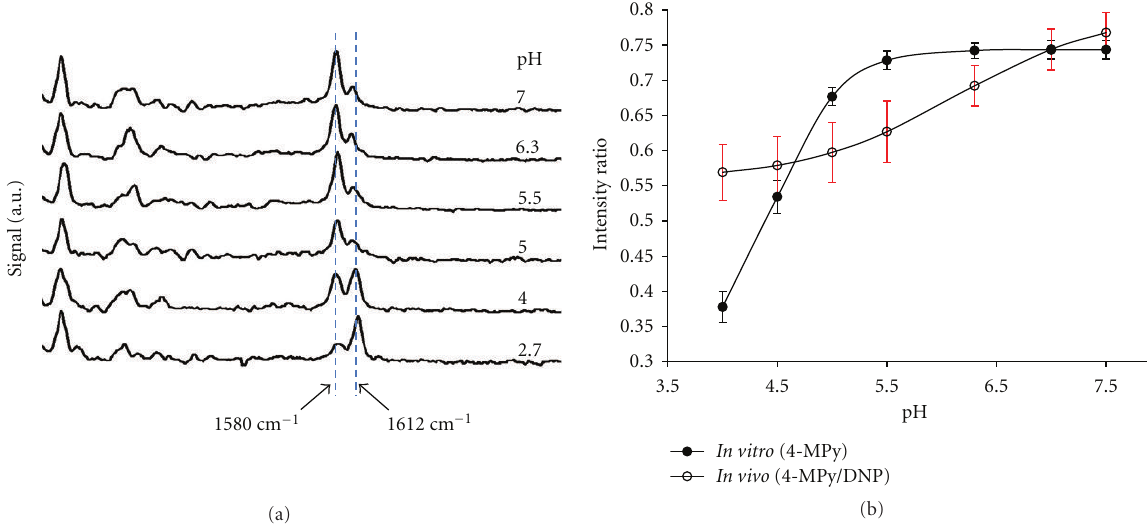
Figure 4: (a) Normalized and o ff set Raman spectra of Au@Ag-4MPy nanoparticles in varying pH-bu ff ered solutions. (b) In vitro (closed circle) calibration curve of Au@Ag-4MPy nanosensors and in vivo (open circle) calibration curves of Au@Ag-4MPy-DNP nanosensors inside RBL-2H3 cells in pH-bu ff ered media containing nigericin. Y -axis represents ratio of integration of peak centered at 1580 cm − 1 versus the additive integration of both the peak centered around 1580 cm − 1 and 1612 cm − 1 . Vertical error bars are dependent on approximately 100 pixels per image, repeated five times.